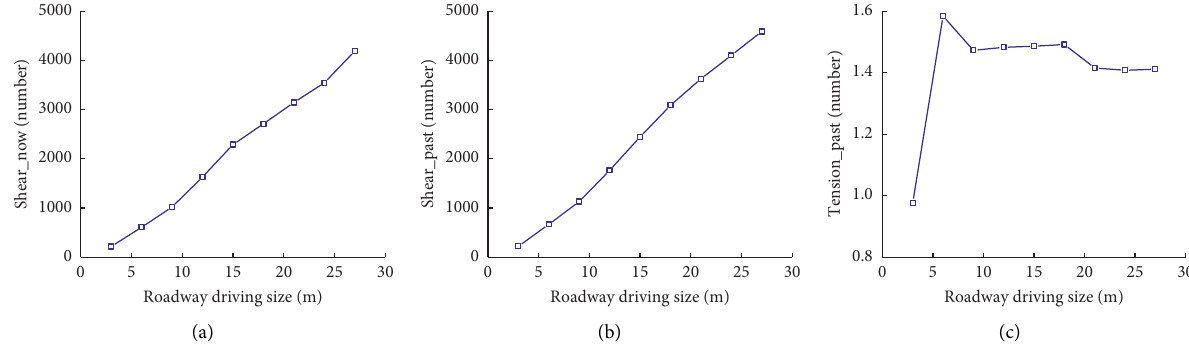
Figure 13: The number of surrounding rock failure units in the process of roadway excavation. (a) Shear-now. (b) Shear-past. (c) Tension-